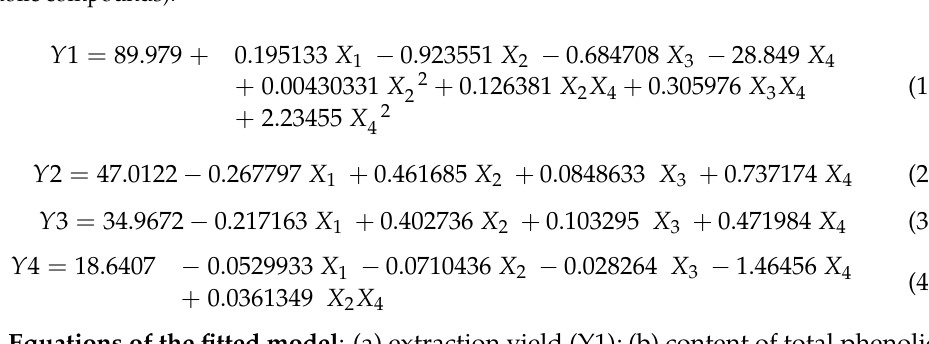
Figure 3. Surface response graphs: ( A ) extraction yield; ( B ) total phenolic compounds; ( C ) phenolic acids; ( D ) flavonoids, and ( E ) optimization of multiple responses (yield and total phenolic com-